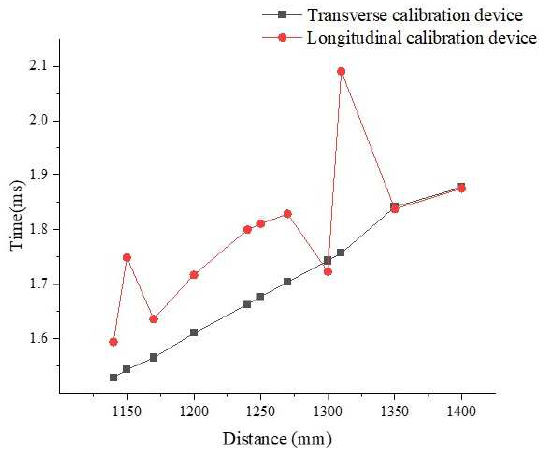
Figure 8. Comparison of 10 kHz ultrasonic transducer’s measurements with two types of ultrasonic- transducer calibration devices.